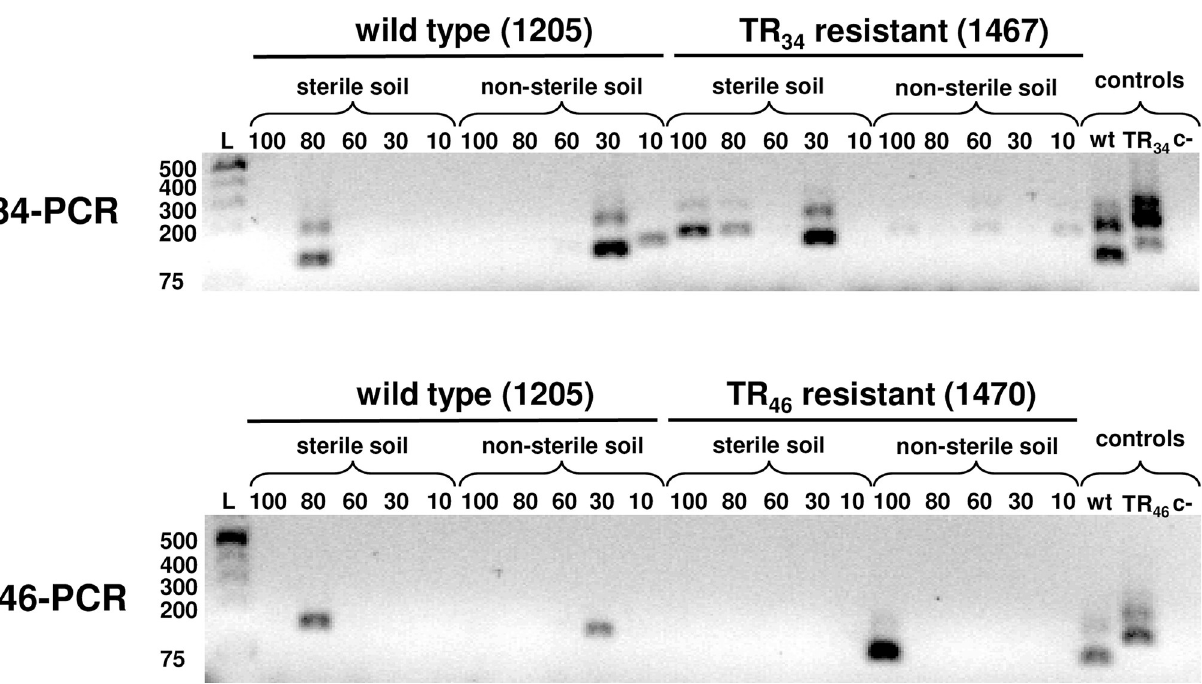
PLOS ONE | https://doi.org/10.1371/journal.pone.0282499 March 3,